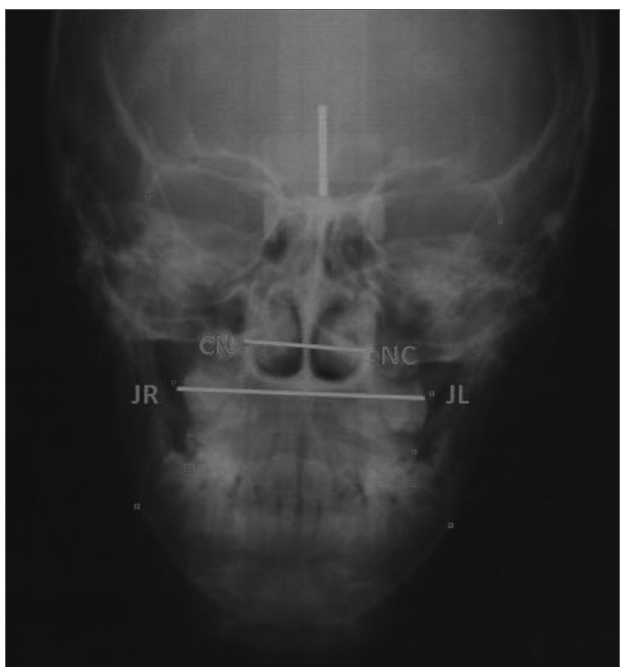
Figura 6. Largura maxilar e nasal. Largura maxilar: medida linear transversal de JL a JR; Largura nasal, medida linear transversal de CN a NC.